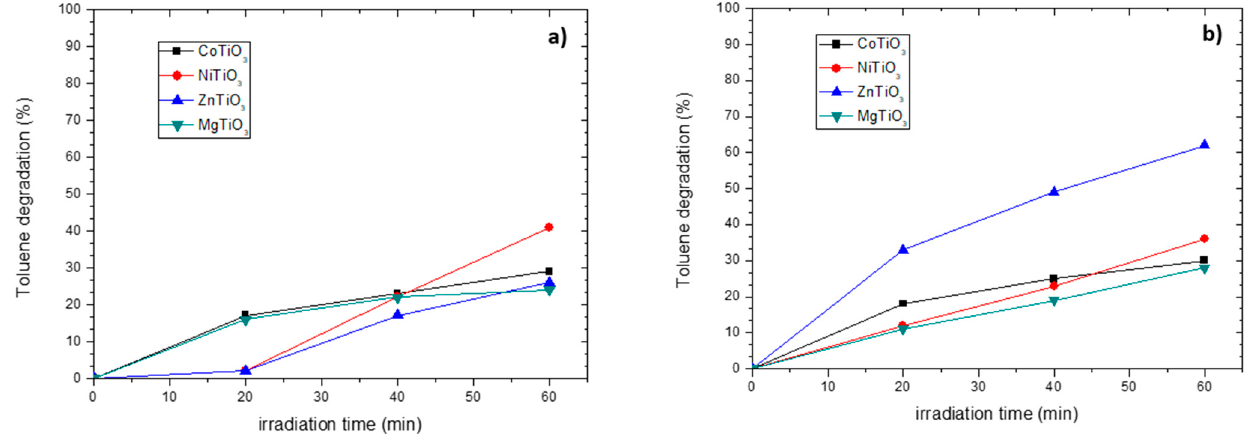
Figure 8. Toluene decomposition under LED irradiation ( a ) λ max = 375 nm and ( b ) λ max = 400 nm of metal titanate nanorods ATiO 3 (A = Mg, Co, Ni, Zn).